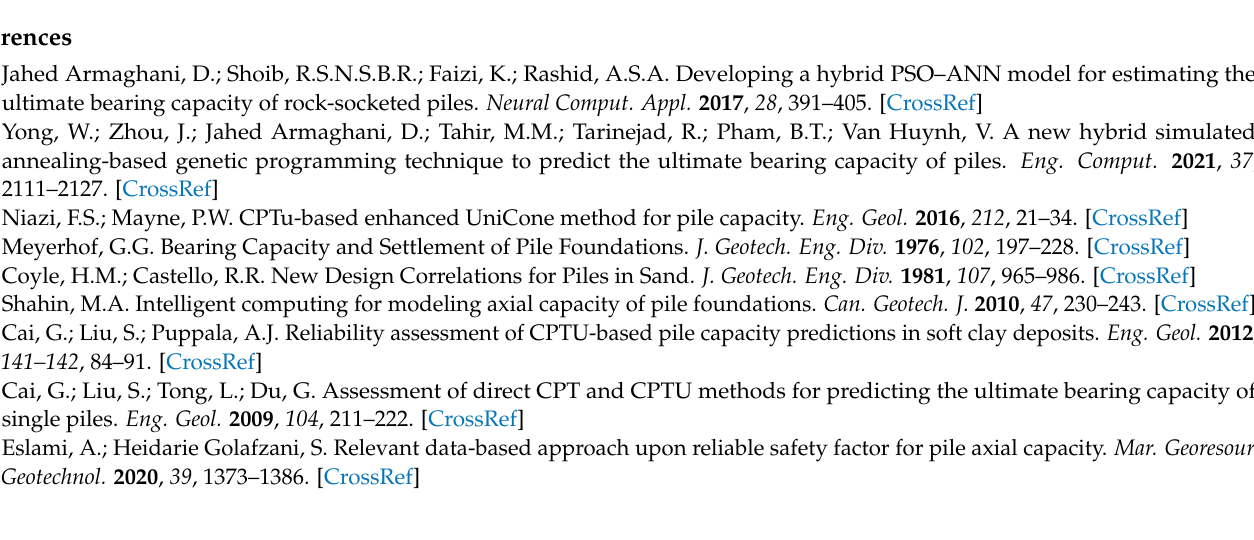
Figure A11. Scatter plots between target and output values by the LS model.